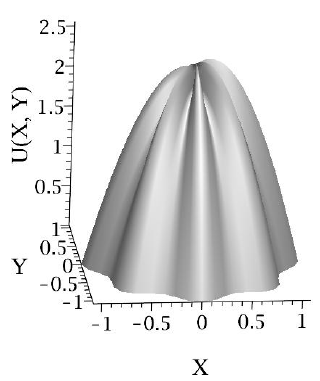
Figure 4. Dimensionless velocity profile (surface curve; 𝜷 = 𝟎.𝟎𝟖 and 𝑵 = 𝟖 ).